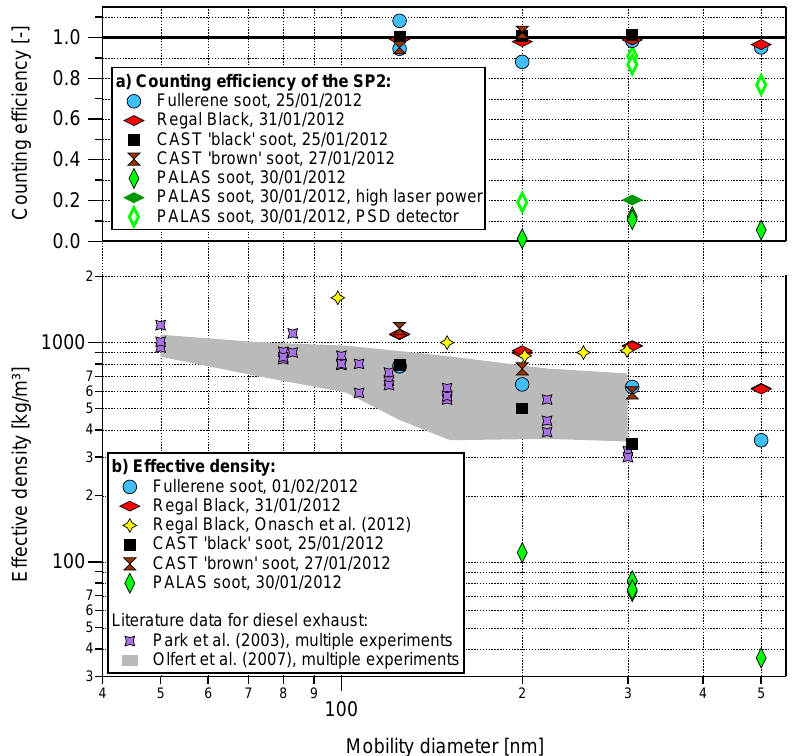
Fig. 2. (a) Counting efficiency of SP2’s incandescence detector (for different BC samples) and position sensitive detector (PSD; for PALAS soot only). (b) Effective density as a function of the particle’s mobility diameter. Literature data of Regal Black’s effective density are from Onasch et al. (2012). Effective density data of diesel exhaust soot are from Park et al. (2003) and Olfert et al. (2007).